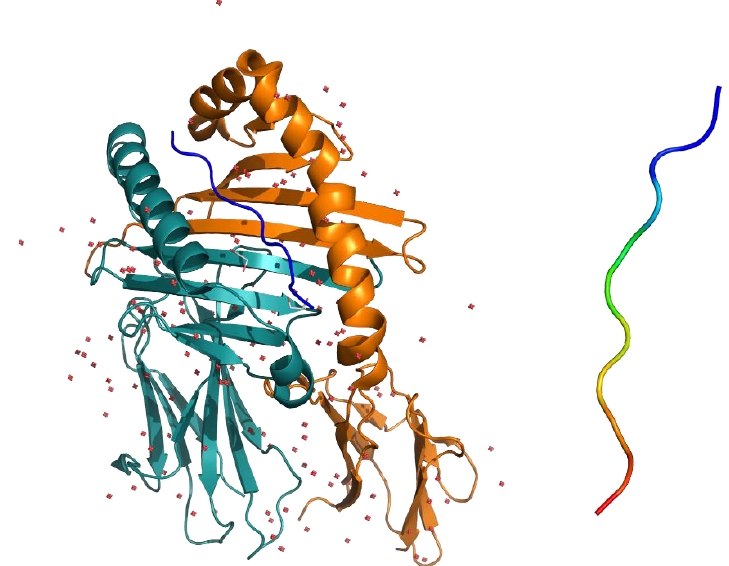
Figure 4. (Left ) X-ray structure of HLA-DQ2.5-glia- α 1 complex (PDB code 1S9V); ( Right ) glia- α 1 structure as found in the complex (color code: blue = N-terminal end, red = C-terminal end.). Di ff erent HLA-DQs show di ff erent specificity for di ff erent gluten peptides because of the